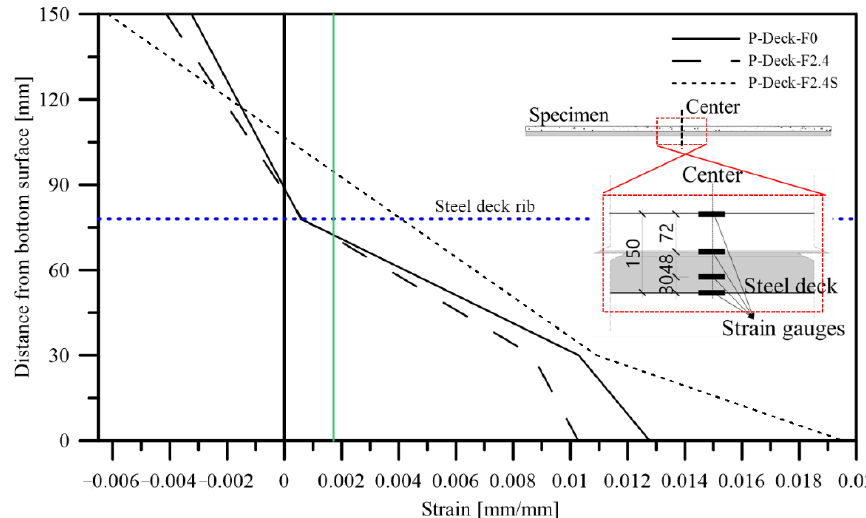
Figure 11. Strain distribution at the center of specimens (unit: mm).